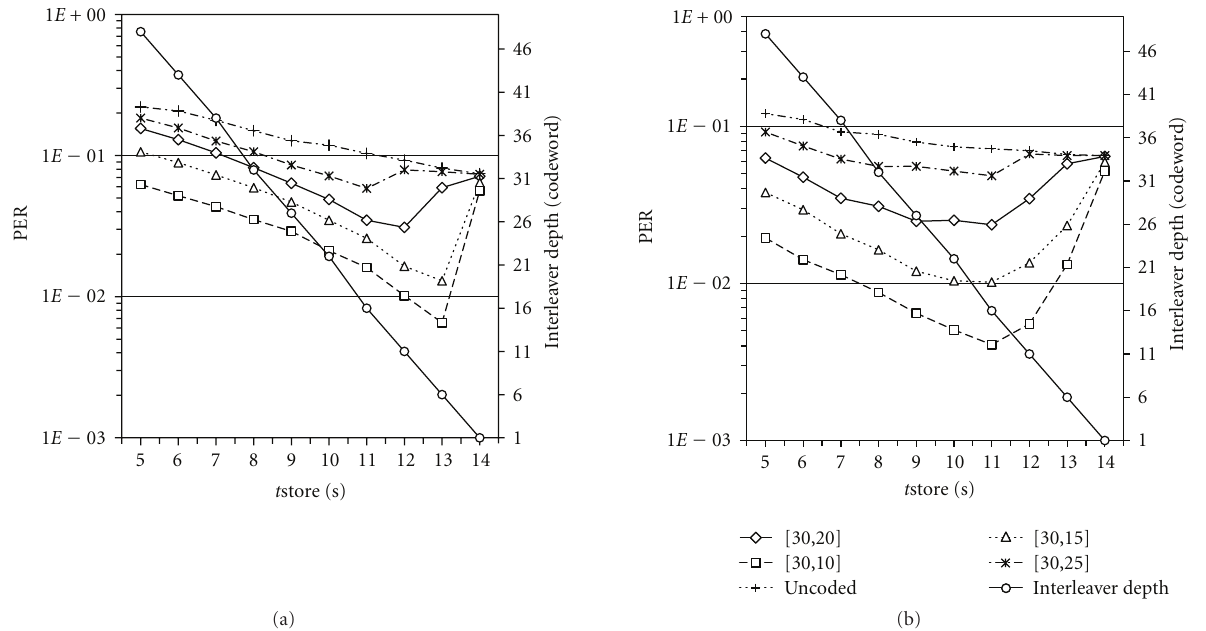
Figure 8: Packet error rate and interleaver depth versus tstore , for a 30-packet codeword in urban Big Bad state (a) and Big Good state (b). In the legenda, the couple ( n , k ) indicates the codeword length ( n ) and the information block length ( k ), respectively.